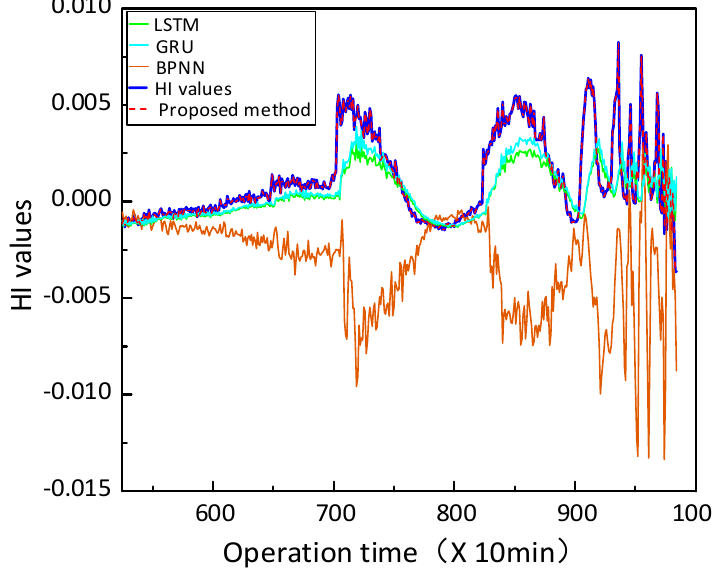
Figure 11. HI prediction results of different methods.